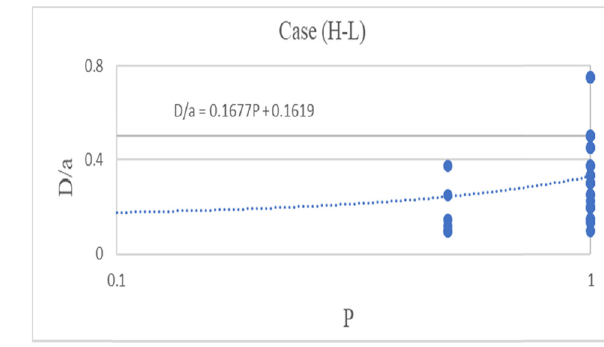
Figure 13: The relation of rootstocks diameter to sluice gate opening ( D / a ) to a trap index ( p ) for cases ( H – L )